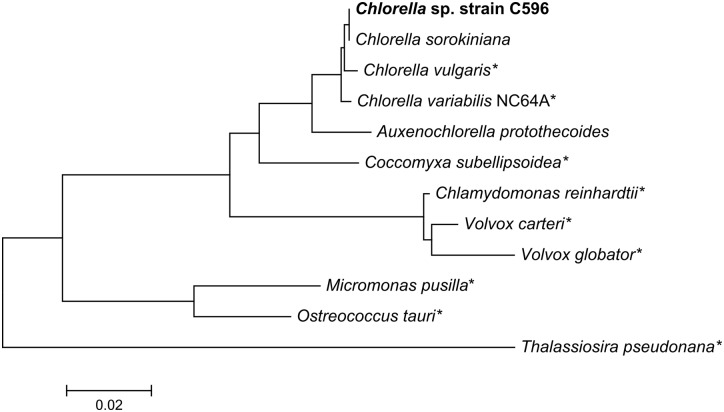
18S rRNA phylogenetic tree for marine and freshwater green algae and a marine diatom outlier.The asterisks indicates organisms with available genomes in the NCBI database. The representative full-length 18S rRNA sequences were aligned with MUSCLE in MEGA 6.